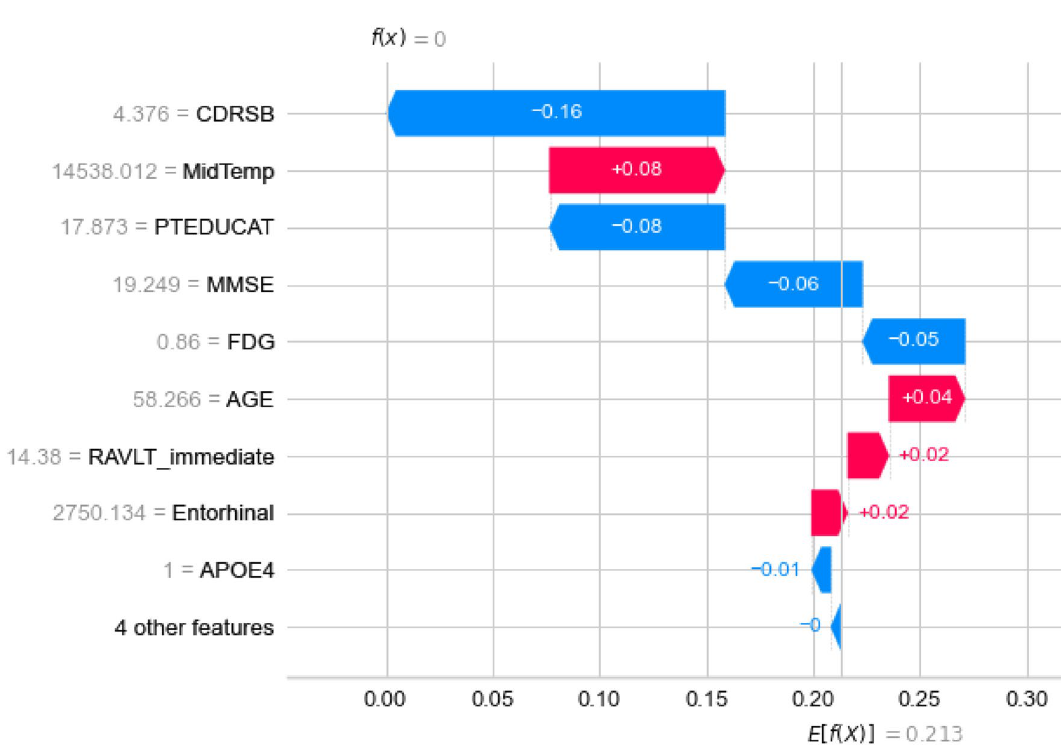
Figure 19. Features influence on a subject with AD diagnosis to be predicted as